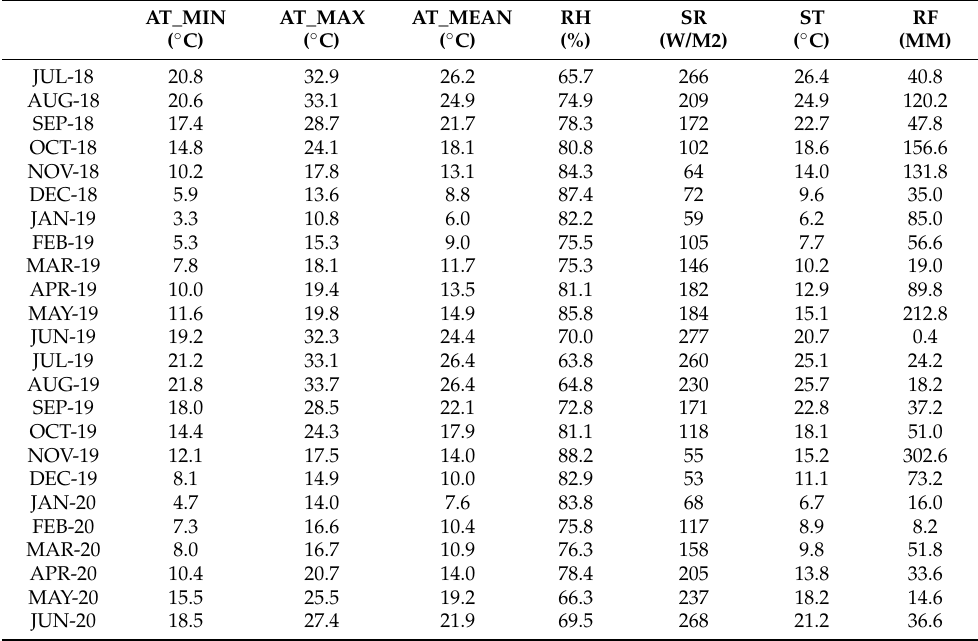
Table 2. Mean monthly meteorological data of the two experimental years (2018–2019 and